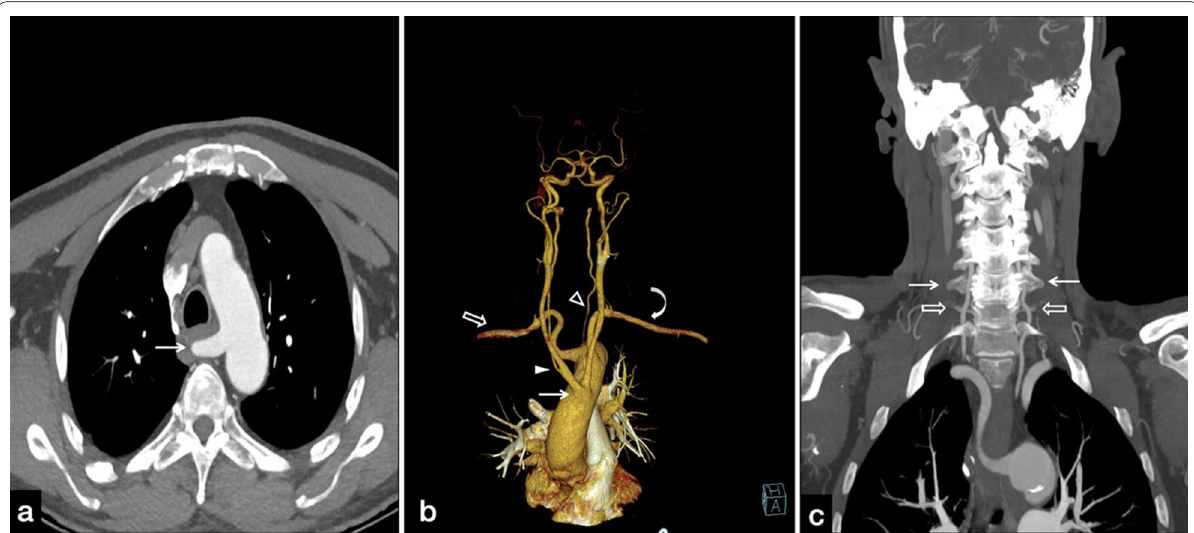
Fig. 1 a Computed tomography angiography image shows the aberrant right subclavian artery originating as the last branch of the aortic arch and showing retroesophageal course (arrow). b Bicarotid trunk (arrow), ARSA (blank arrow), RCCA originated RVA (arrowhead) and aortic arch origin LVA (blank arrowhead) are seen in 3D reconstruction images. LSCA exits from the proximal of the ARSA (curved arrow). c Maximum intensity projection of computed tomography angiography image shows that both vertebral arteries enter the transverse foramen at the C6 vertebral level (arrows). C7 vertebra is shown with blank